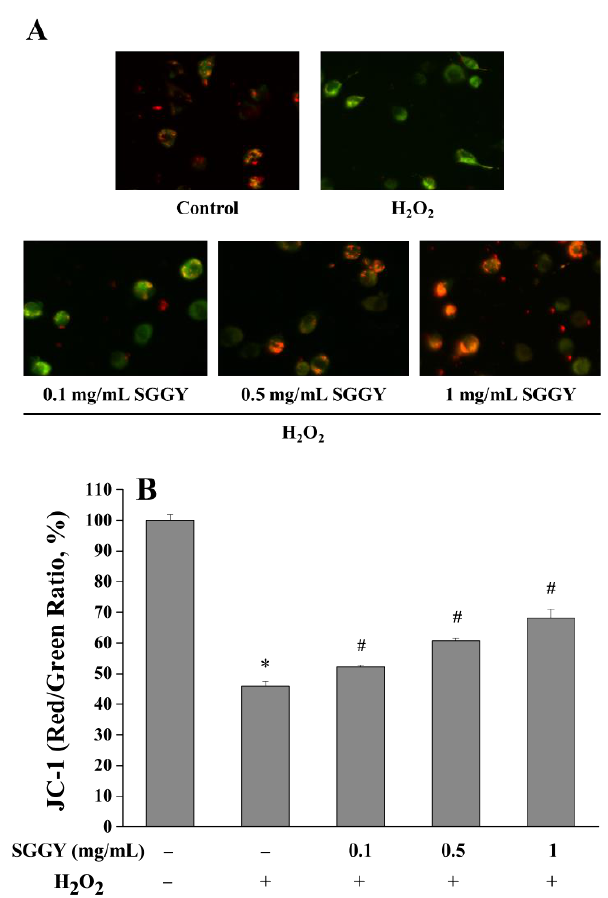
Figure 4. SGGY ameliorated H 2 O 2 -induced mitochondrial dysfunction in SH-SY5Y cells. Cells were pre-incubated with different concentrations of SGGY (0.1, 0.5, and 1 mg/mL) for 12 h and subsequently exposed to 900 µ M H 2 O 2 for 2 h. After being incubated with JC-1, the changes in MMP were visualized by a fluorescence microscope. The red colors represented normal mitochondrial membrane potential in SH-SY5Y cells, and the green colors represented that mitochondrial membrane potential was decreased. ( A ); the fluorescence intensities of JC-1 were measured by a fluorescence microplate reader ( B ). * p < 0.05 vs. control group, and # p < 0.05 vs. H 2 O 2 group.